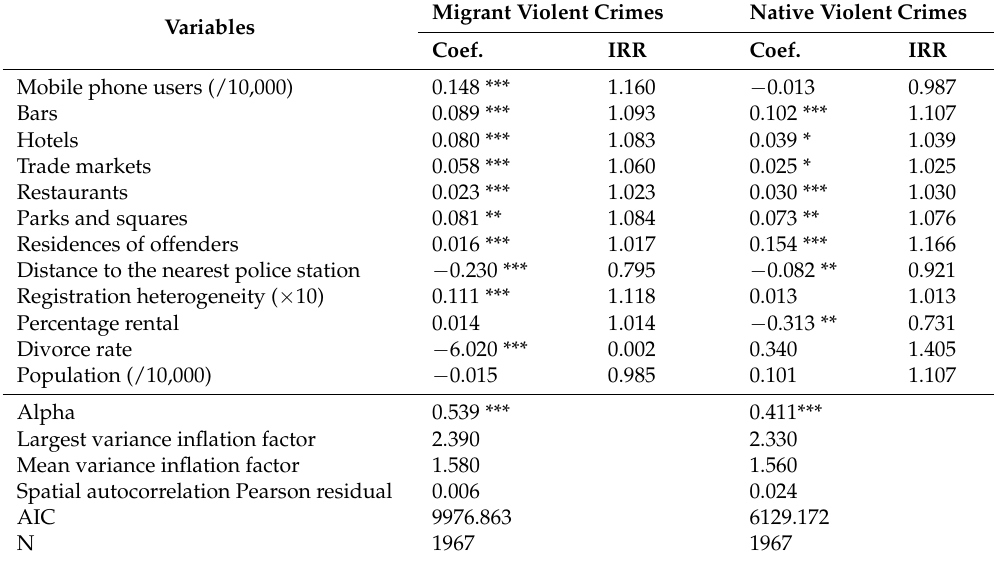
Table 4. Negative binomial regression models of migrant and native violent crimes per neighborhood. Both coefficients (Coef.) and incidence rate ratios (IRR) are presented.